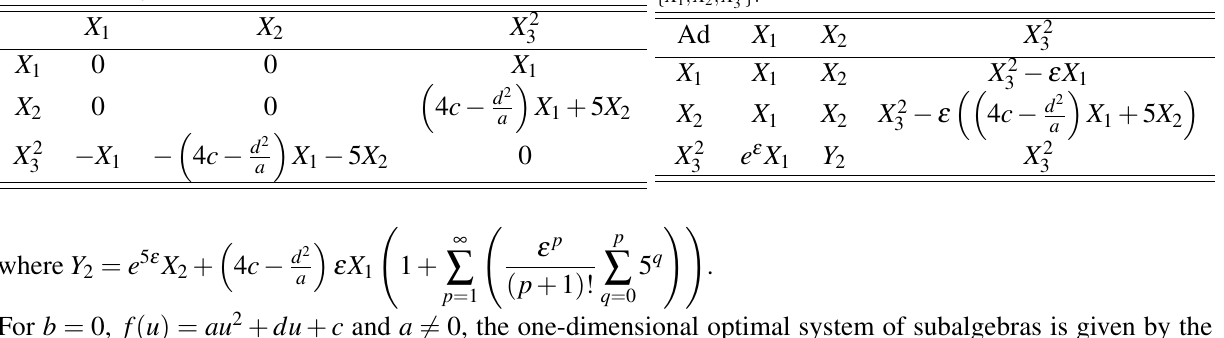
Table 3: Commutator table for the Lie algebra { X 1 , X 2 , X 2 3 } .